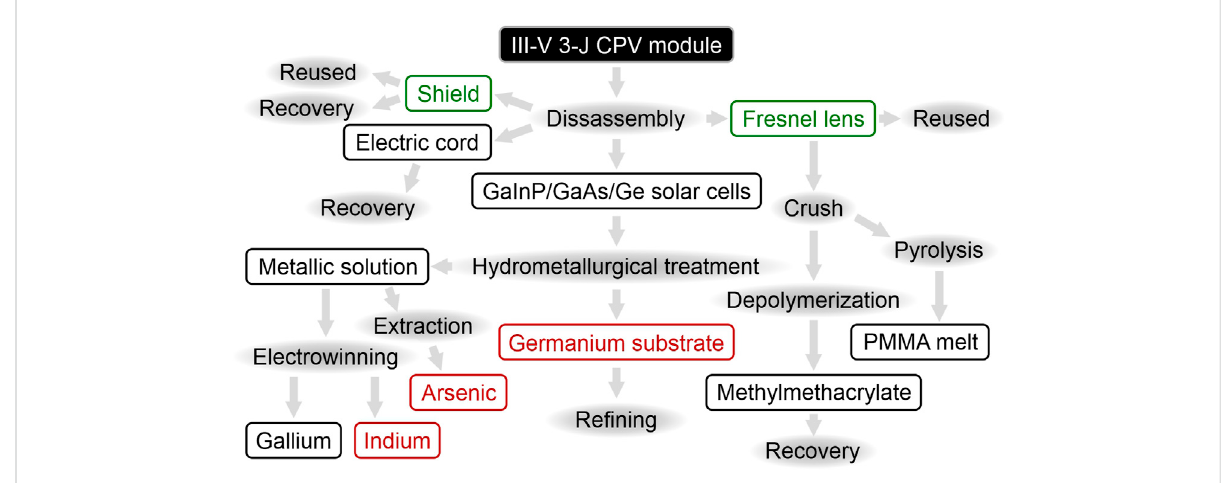
FIGURE 11 Simpli fi ed recycling process for III-V//Ge 3-J solar cells. Marked in red are the most critical components to recycle due to price or toxicity. Marked in green are the components, which can be reused if not mechanically damaged. Image adapted from (Wang,